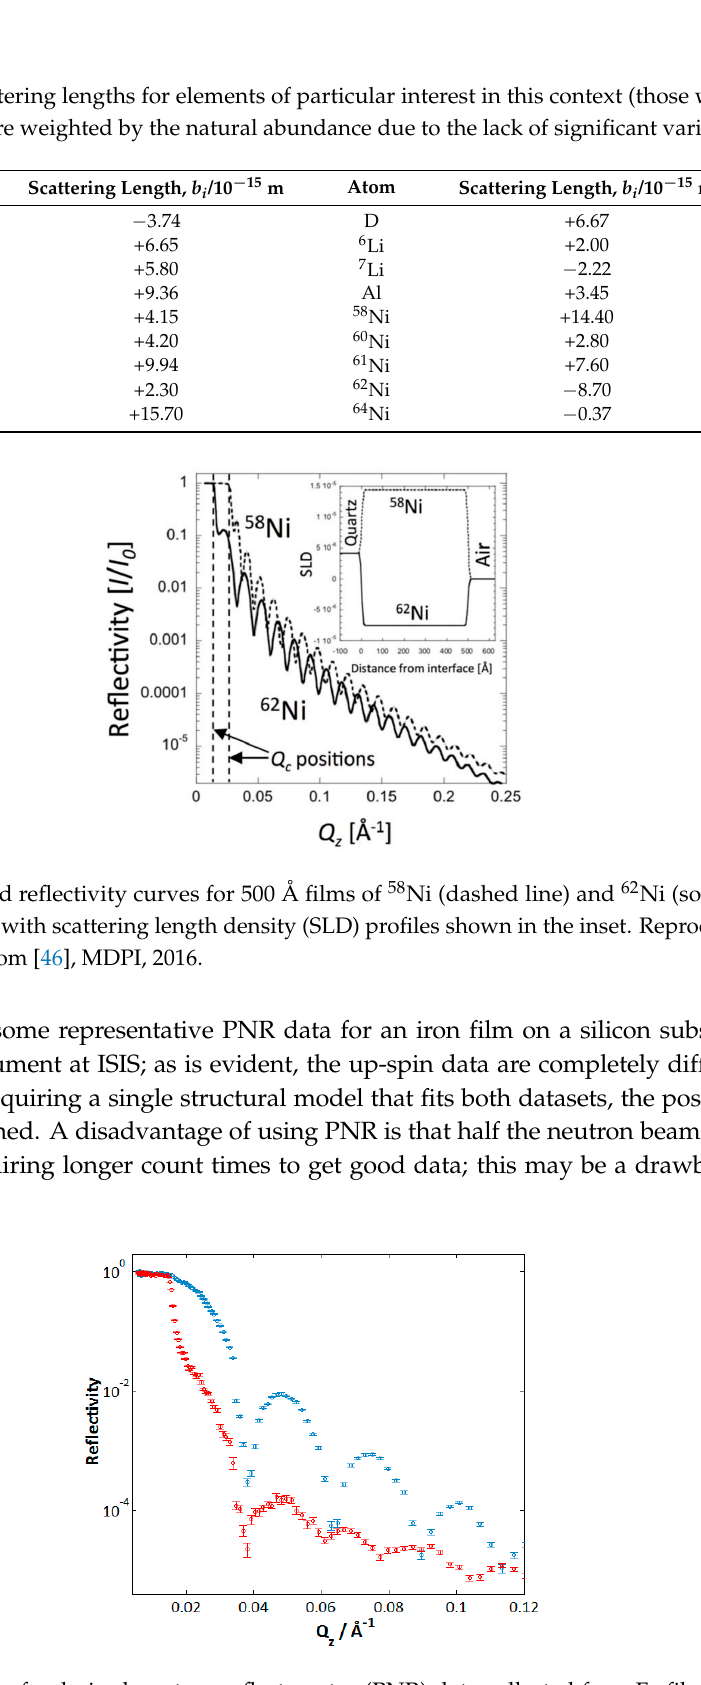
Figure 4. Example of polarised neutron reflectometry (PNR) data collected for a Fe film on silicon substrate, showing up-spin (blue) and down-spin (red) data collected on POLREF at the ISIS neutron source (doi:10.5286/ISIS.E.24088548).